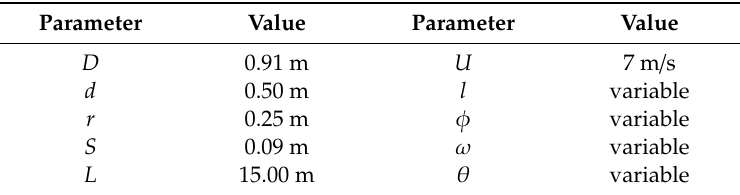
Table 1. Parameters of the building-integrated